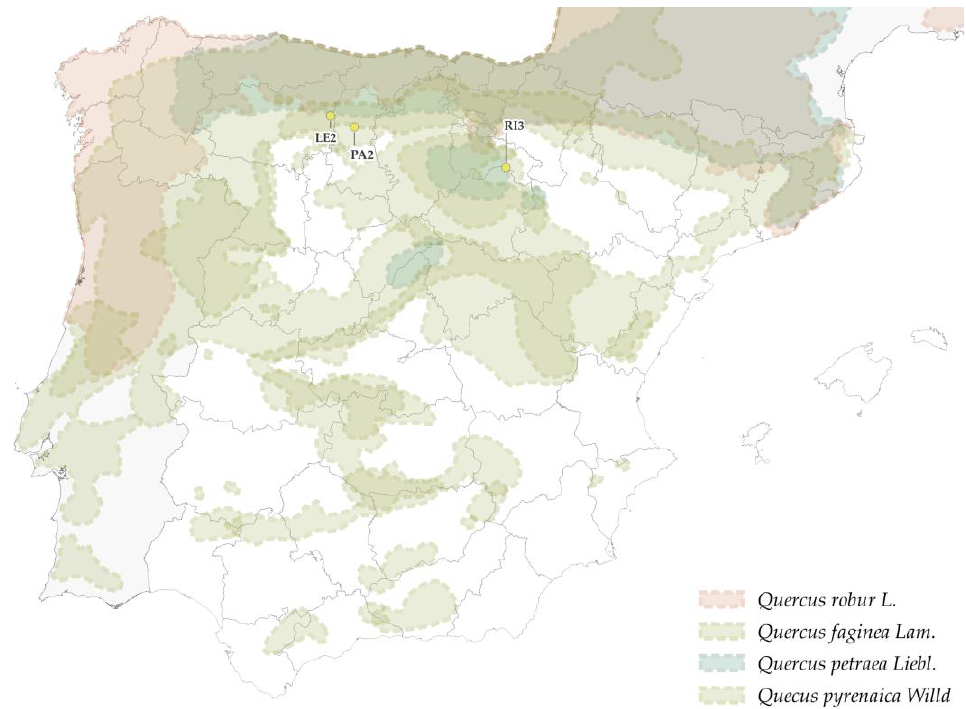
Figure 11. Distribution map of the species Quercus robus L., Quercus faginea Lam., Quercus petraea Liebl., and Quercus pirenaica Willd and location of the case studies identified as belonging to this group of species. Map drawn up by the authors using the information obtained from the database Chorological Data for the Main European Woody Species [42].